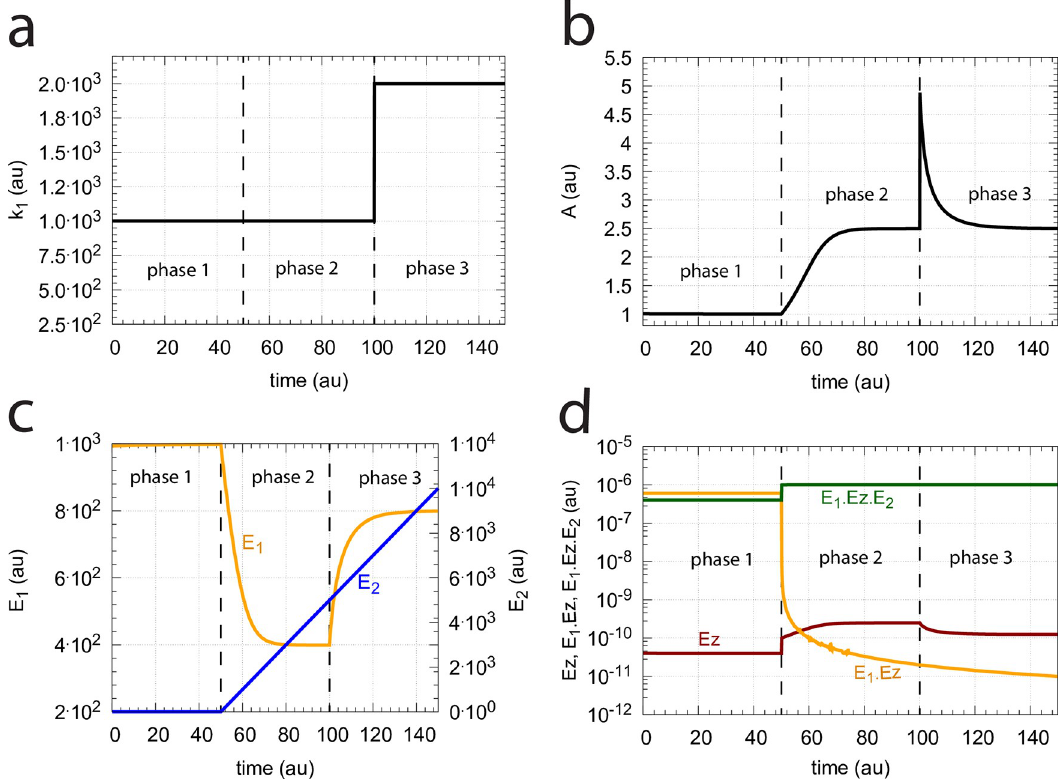
Fig 36. Switch from dual-E control to single-E in the compulsory ternary-complex mechanism of motif 5 when E 1 binds first to free Ez (Fig 35). (a) Perturbation k 1 as a function of time. (b) Change of the controlled variable A ’s concentration as a function of time. Phase 1: dual-E control; phases 2 and 3: single-E control. (c) Concentration of E 1 and E 2 as a function of time. (d) Concentration of the enzymatic species Ez , E 1 � Ez , and E 1 � Ez � E 2 as a function of time. Rate constants: k 1 =1000.0 (phases 1 and